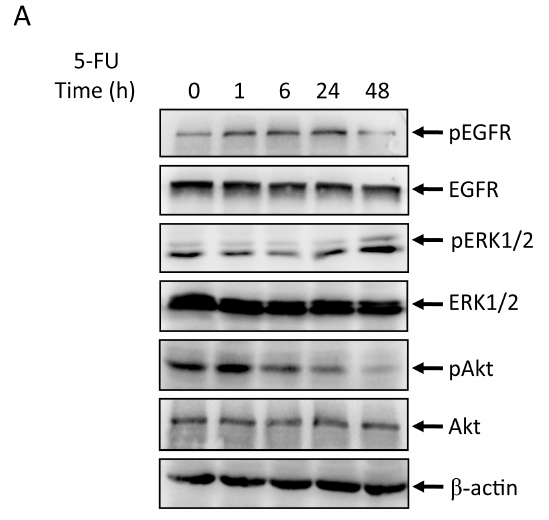
Figure 2. Effects of 5-FU on pEGFR, EGFR, pERK, ERK, pAkt and Akt expression in MGC803 cells. MGC803 cells were treated with 2 µg/mL 5-FU for the indicated